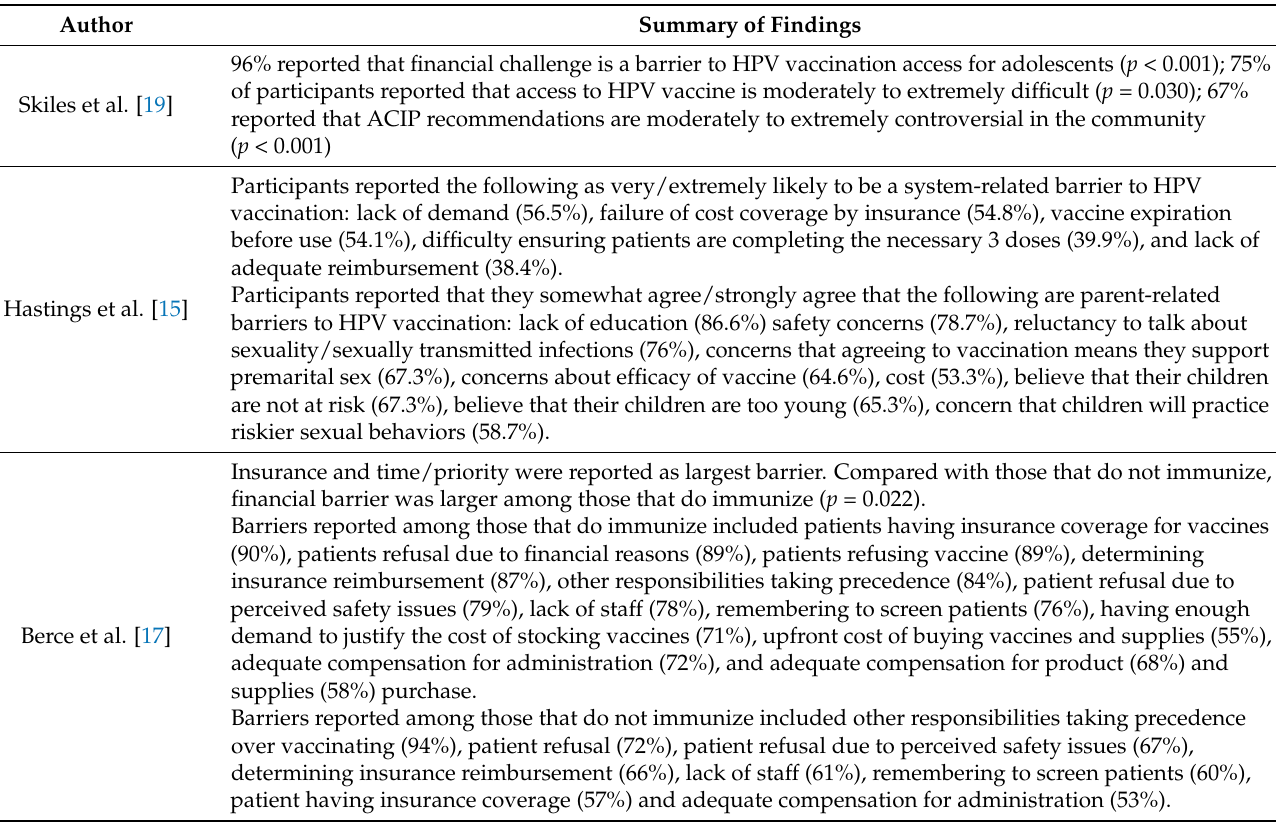
Table 3. Key findings of included